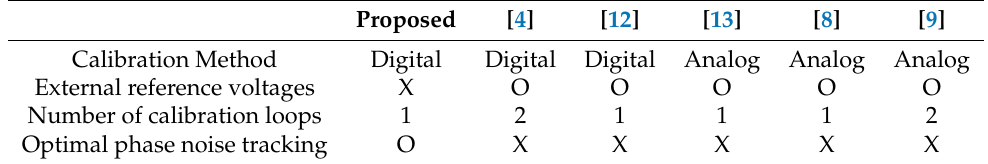
Figure 12. Post-layout simulation transient response of bias voltage in NN, FF, SS, 125 ◦ C, − 40 ◦ C corners. Table 1. Comparison of characteristics of bias calibration for Class-C VCO.